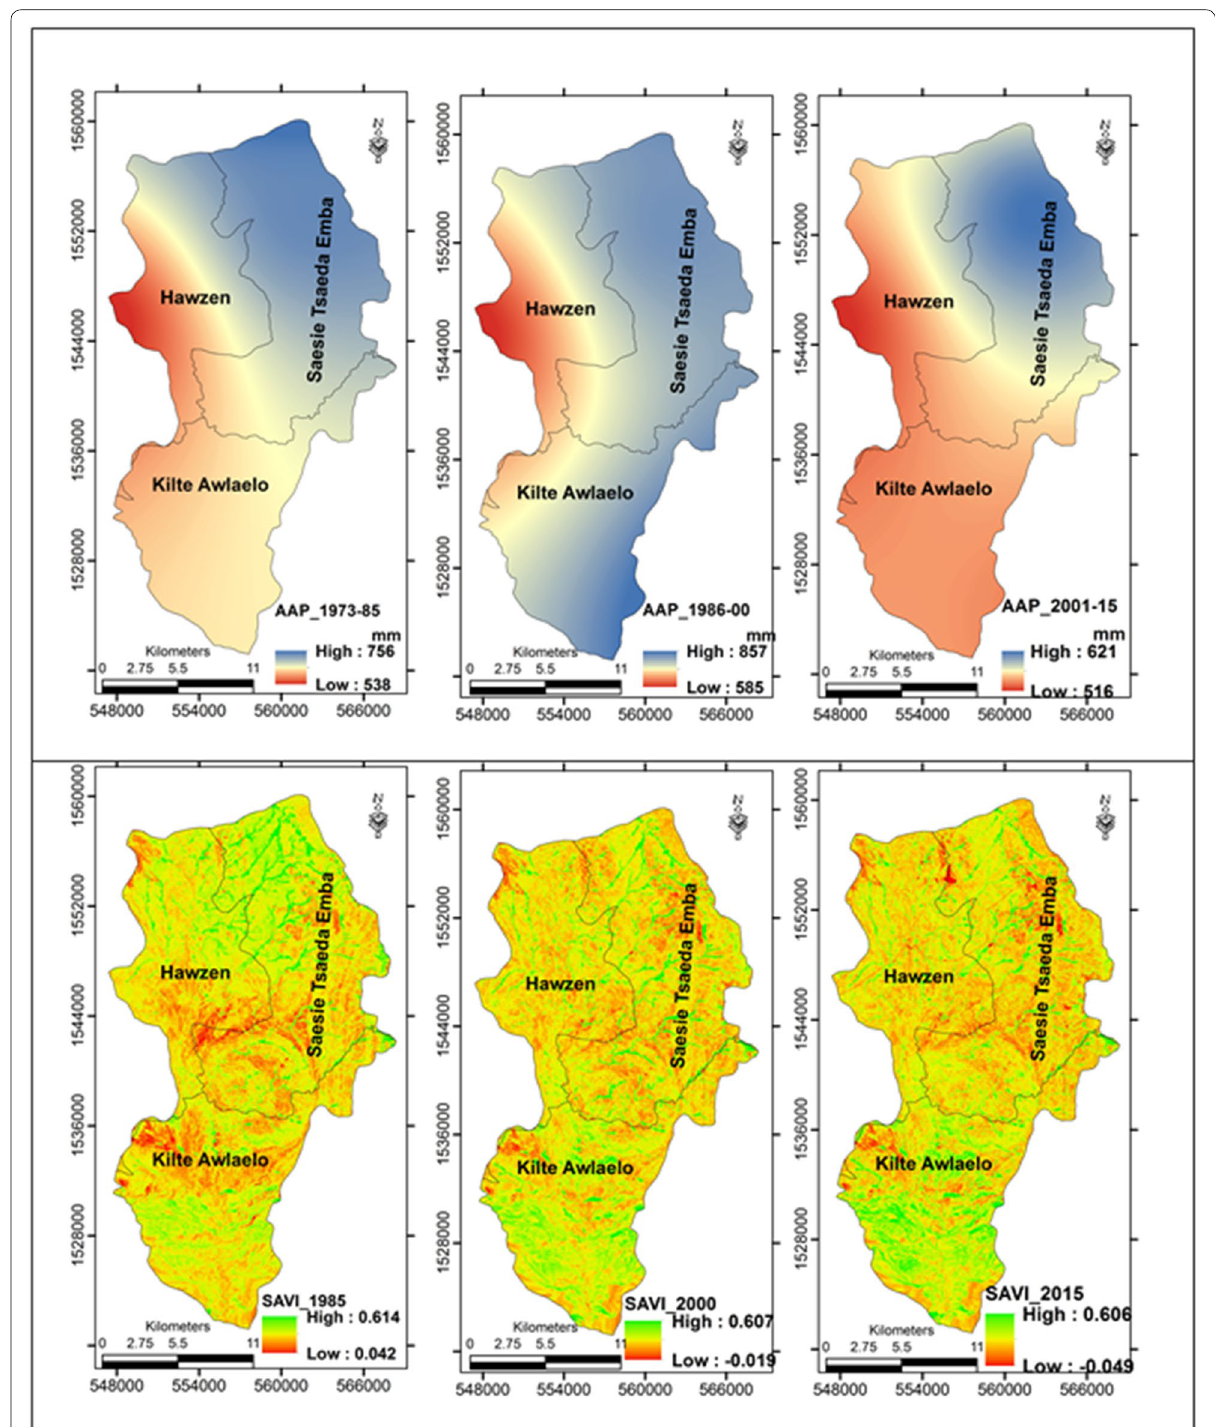
Fig. 3 IDW interpolation of average annual precipitation (top) and SAVI (bottom) for 1985, 2000, and